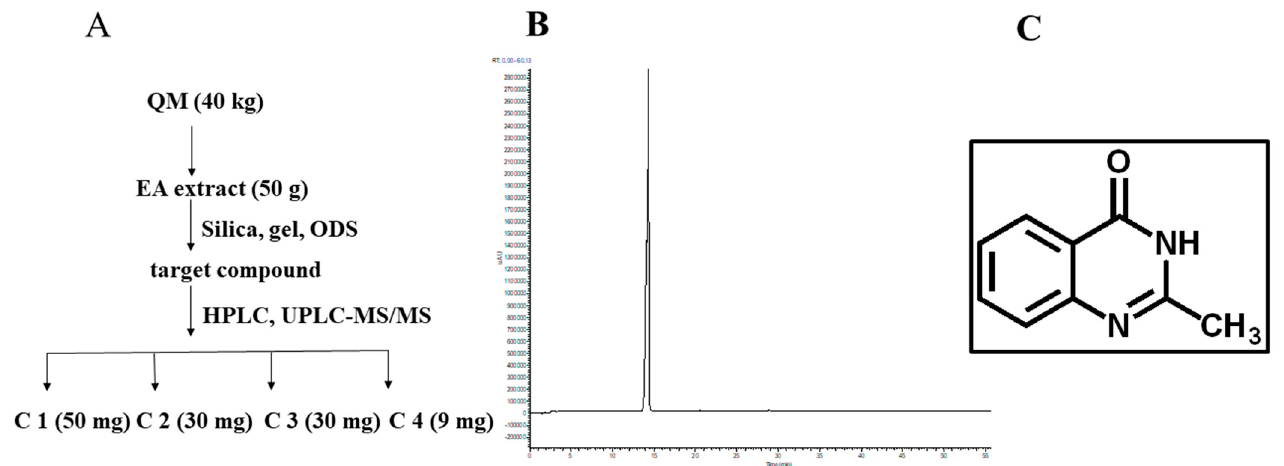
Figure 1. Preparation C1 in QM. ( A ) Enrichment of target compound from QM decoction; ( B ) HPLC chromatogram of C1; ( C ) Structure of compound 1. C1 was isolated using silica, gel and ODS, and further tracked by UPLC − LTQ − MS and purified preparative HPLC. A white amorphous power, with a molecular of C 9 H 8 N 2 O, which was determined by the ESIMS ion at m / z 161.16. The UPLC − MS n fragments (160.99, 144.94, 120.08) indicated that C1 is a quinazolinone alkaloid.